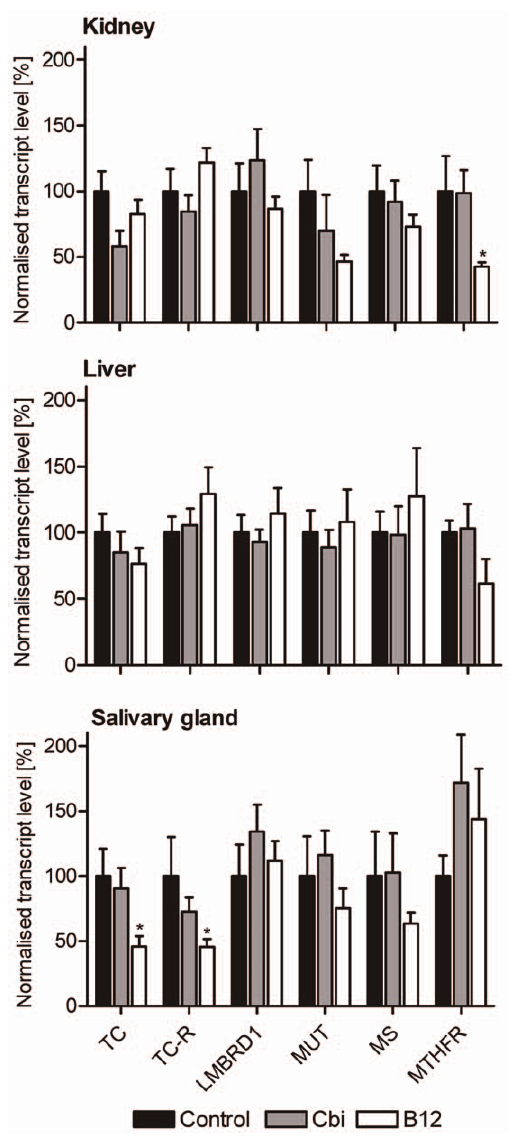
Figure 3. Changes in transcript levels after treatment of mice with Cbi or B12. Kidney, liver and salivary glands were removed from mice treated for 27 days with saline (control, n=7), 4.25 nmol/h Cobinamide (Cbi, n=7) or 1.75 nmol/h vitamin B12 (B12, n=7). We analysed the transcript levels by q–rt–PCR. The results (Mean + SEM) for each sample are relative to the mean value for the corresponding tissue from control mice. Non–parametric Wilcoxon tests were employed to calculate significant differences, p , 0.05 are indicated with * for comparison to control mice. No significant difference was observed between Cbi and controls or Cbi and B12 mice. LMBRD1: lysosomal B12 transporter. MS: methionine synthase. MTHFR: methylenetetrahydrofo- late reductase. MUT: methylmalonyl–CoA mutase. TC: transcobalamin. TC–R: transcobalamin receptor (CD320).